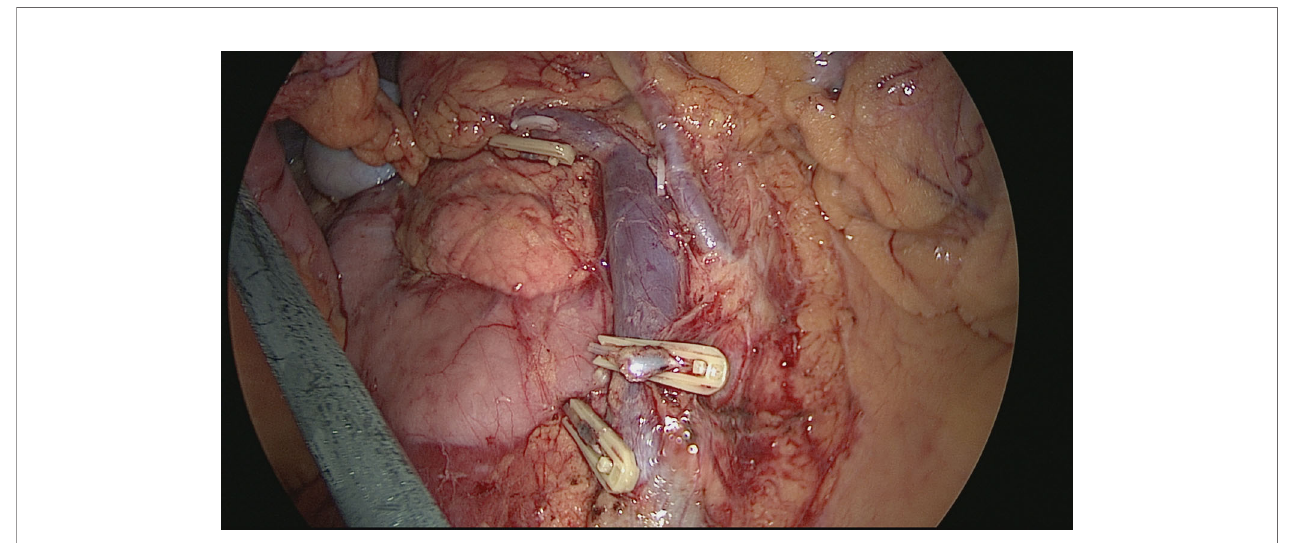
FIGURE 3 | A vessel-priority D3 dissection + CME.